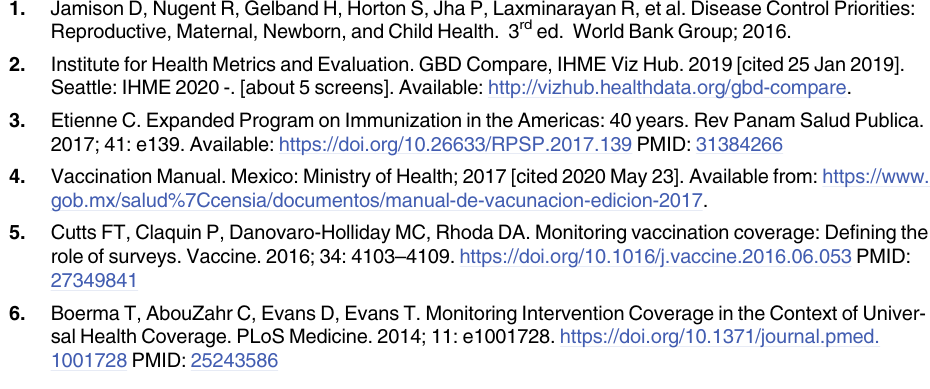
S1 Table. Estimated vaccination coverage of two basic schemes according to accumulated doses and age groups, Mexico 2000–2018. BCG, Bacillus Calmette-Guerin vaccine; PV, com- plete cells pentavalent vaccine; PVa, acellular pentavalent vaccine; HB, Vaccine against Hepati- tis B; Pnm, Conjugate vaccine against Pneumococcal; RV, Vaccine against rotavirus; MMR, Vaccine against measles, mumps, and rubella. a Vaccination scheme valid during the 2000 and 2006 surveys. b Vaccination scheme valid during the 2010, 2012 and 2018. The boost doses